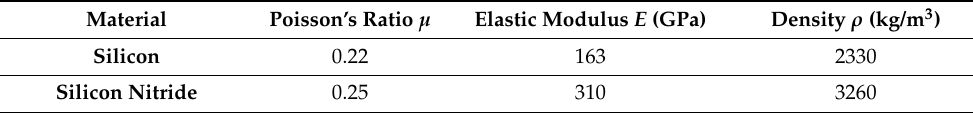
Figure 3. Normalized central deformation y ( p ) of silicon and silicon nitride diaphragms at different R/h ratios. Table 1. Characteristic material parameters of silicon and silicon nitride utilized in the design.